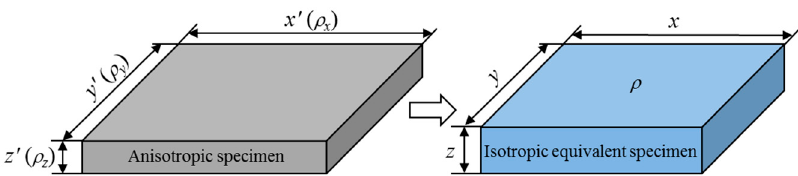
Figure 4. Wasscher’s transformation of an anisotropic specimen to an isotropic equivalent specimen.